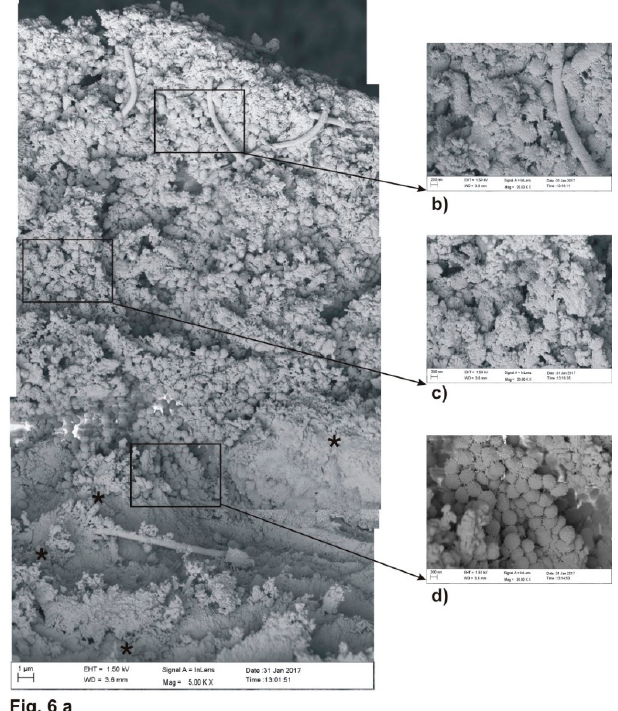
Figure 6. Fractured 5-days-grown biofilm demonstrating the stratification. ( a ) Overview, ( b ) basic layer with cocci, ( c ) middle layer showing cocci, and ( d ) surface layer with loose bacteria and some extracellular matrix.